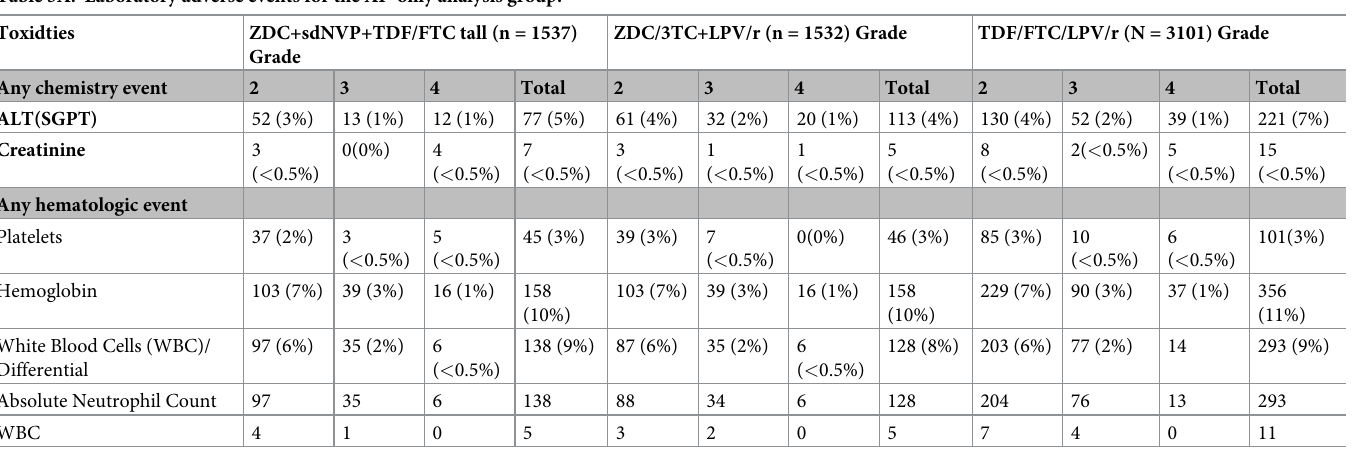
Table 3A. Laboratory adverse events for the AP-only analysis group.